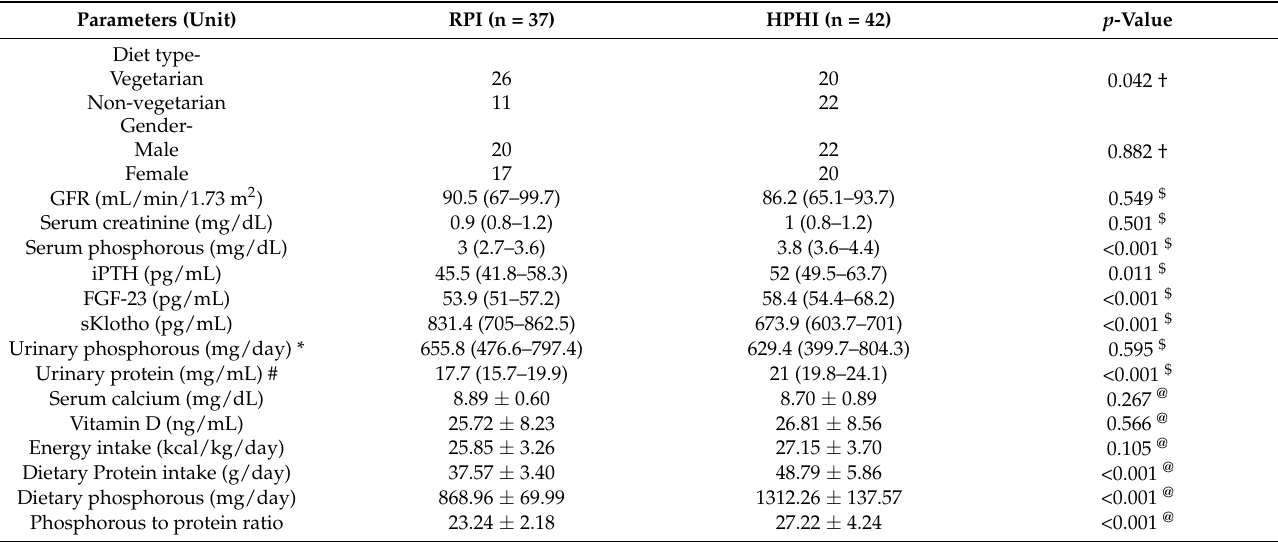
Table 4. Demographic and baseline biochemical data of the CKD patients based on their dietary phosphorous intake (mg/day).